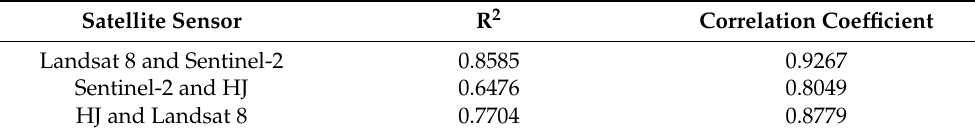
Figure 4. Correlation analysis of NDVI value based on random points (The figures include the conversion equation and correlation coefficient between every pair of sensors for NDVI. ( a ) shows the fitting result of NDVI between Landsat 8 and Sentinel-2; ( b ) shows the fitting result of NDVI between Sentinel-2 and HJ; ( c ) shows the fitting result of NDVI between HJ and Landsat-8). Table 3. The NDVI fitting results in the South Dump under multi-source sensor monitoring.